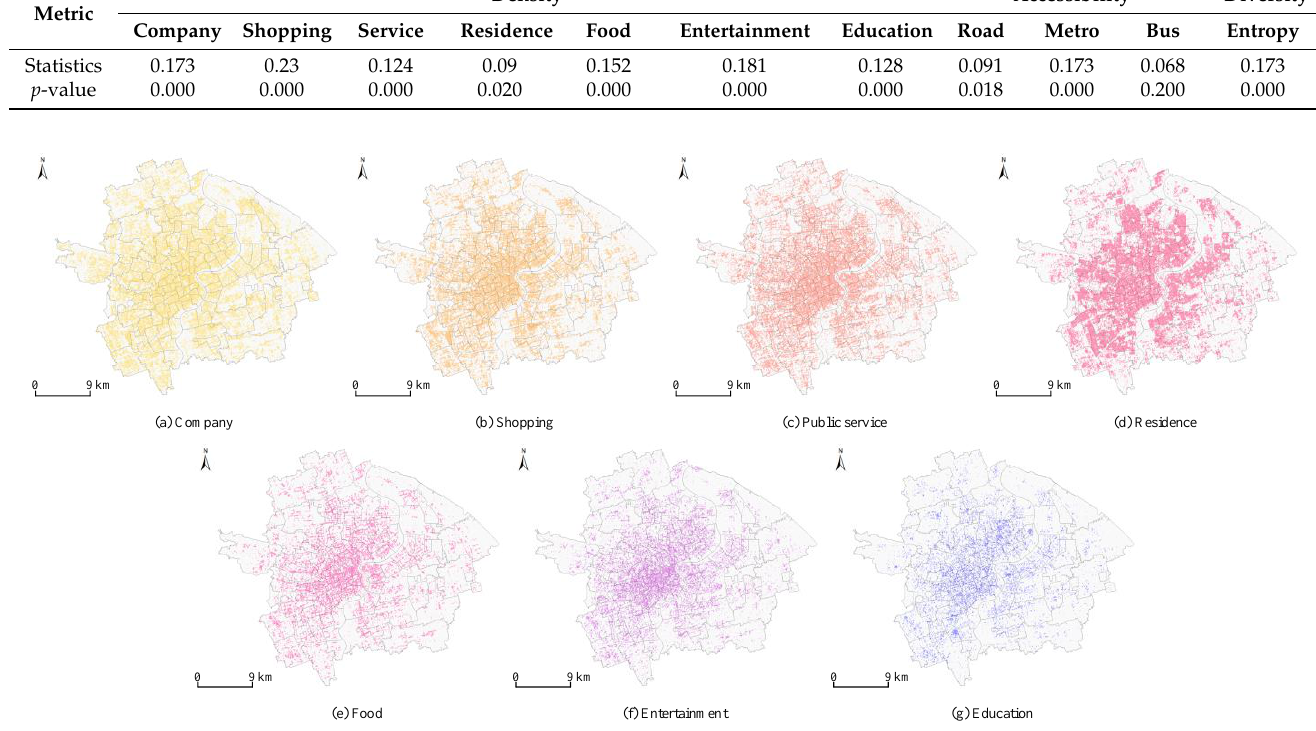
Figure A1. The distribution of POIs by category (each point represents a POI).